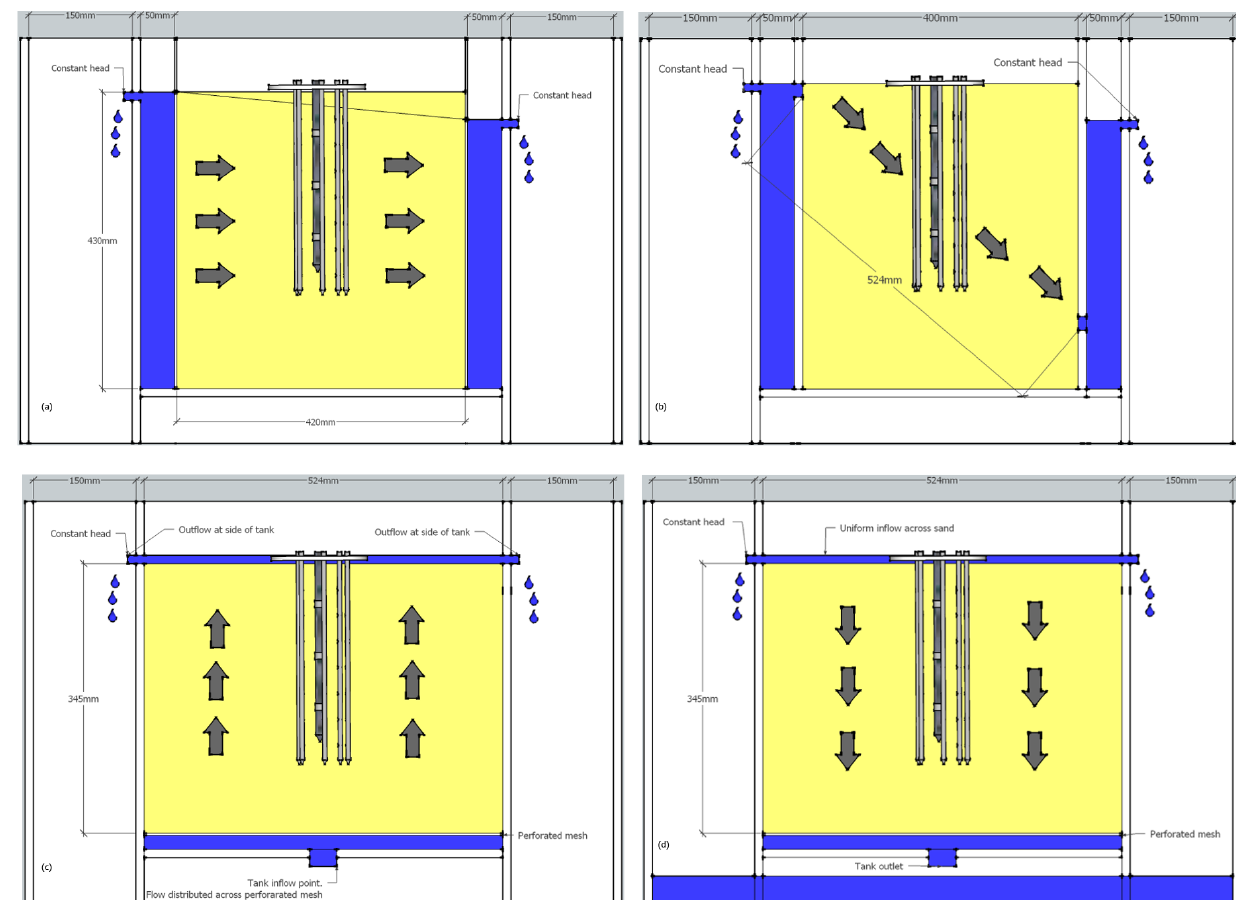
Figure 3. Laboratory sand tank dimensions for each of the flow scenarios: (a) horizontal flow, (b) diagonal flow, (c) upward flow and (d) downward